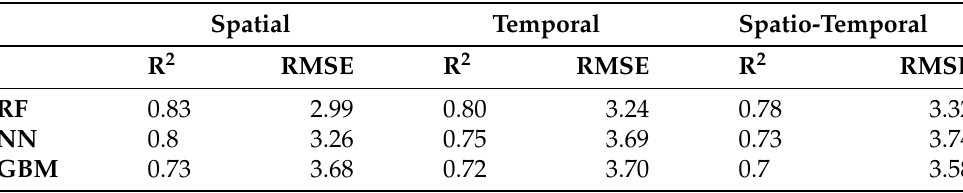
Table 3. Performance of the final models as R 2 and RMSE for each of the three algorithms RF, NN and GBM with respect to the three external validation